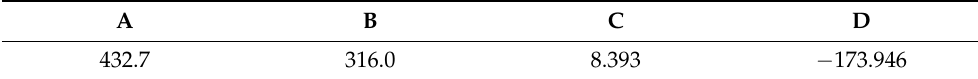
Table 6. Modified Voce constitutive equation coefficients of material AA5182.